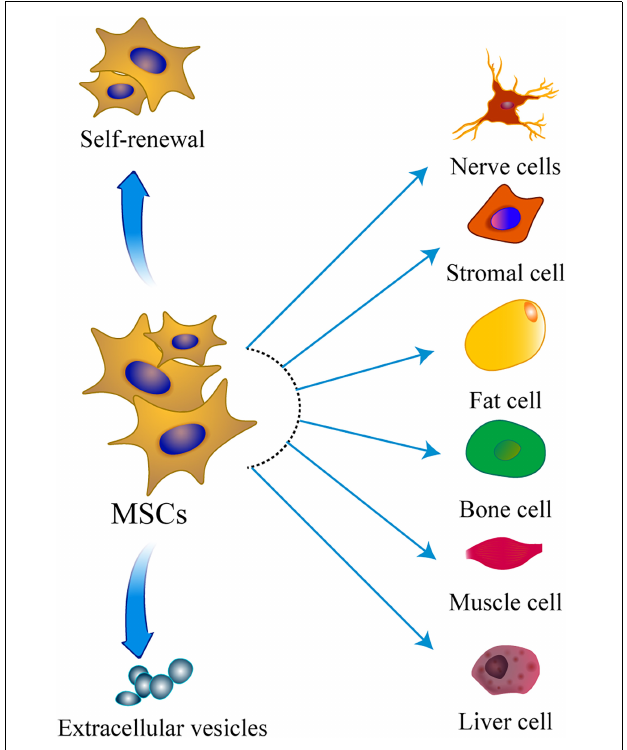
FIGURE 1 | The multipotentiality of MSCs. This figure shows the ability of MSCs to self-renew, secrete extracellular vesicles, and differentiate toward the mesodermal, ectoderm, and endoderm